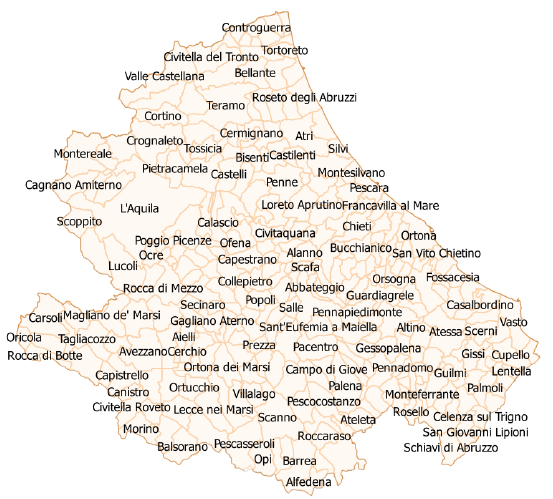
Figure 14. The municipalities of the Abruzzo